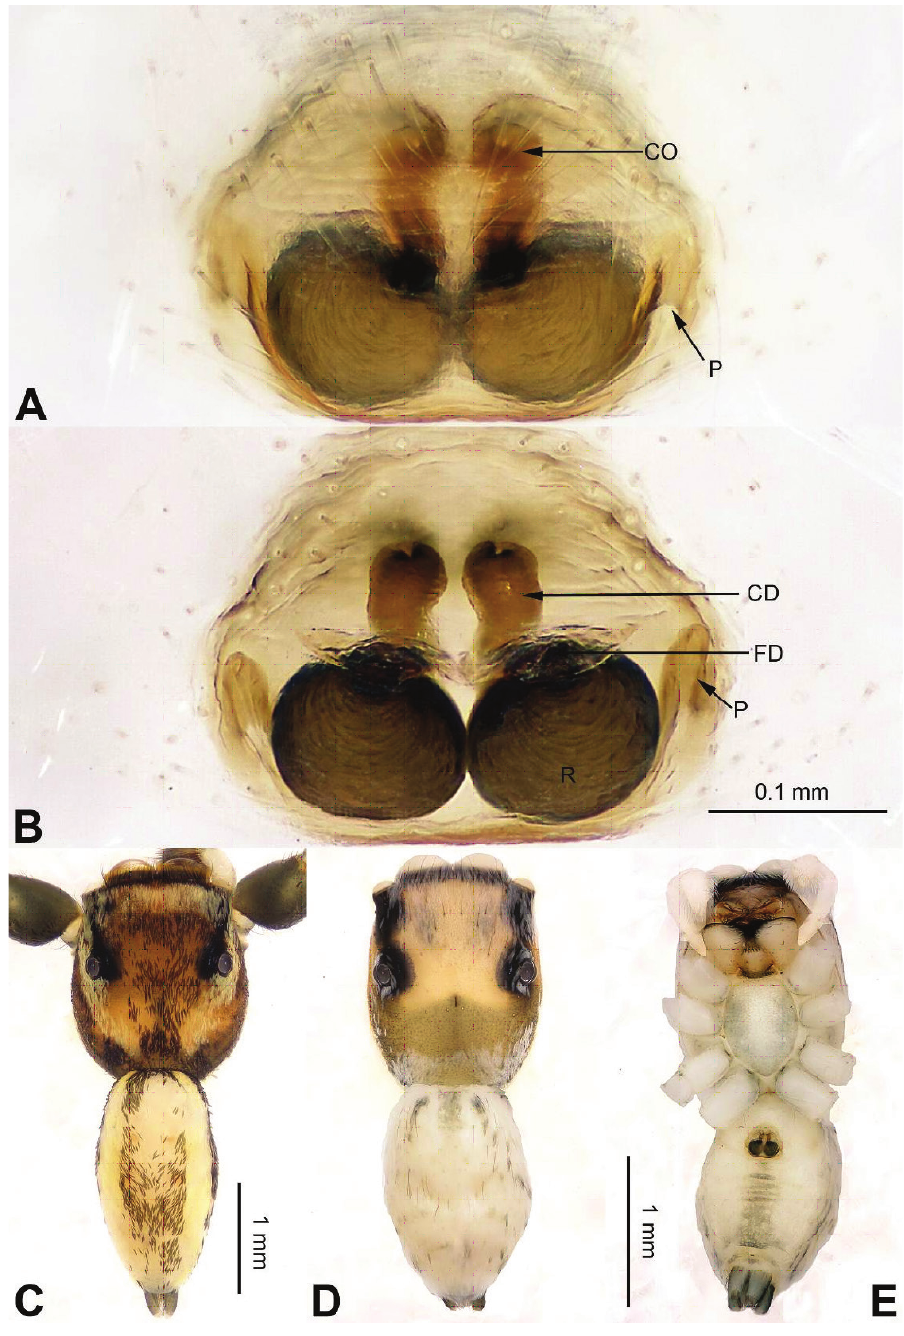
Figure 37. Phintella suavisoides , female and male from Xishuangbanna. A epigyne, ventral B vulva, dorsal C male habitus, dorsal D female habitus, dorsal E female habitus, ventral. Scale bars equal for A and B ; equal for D and E